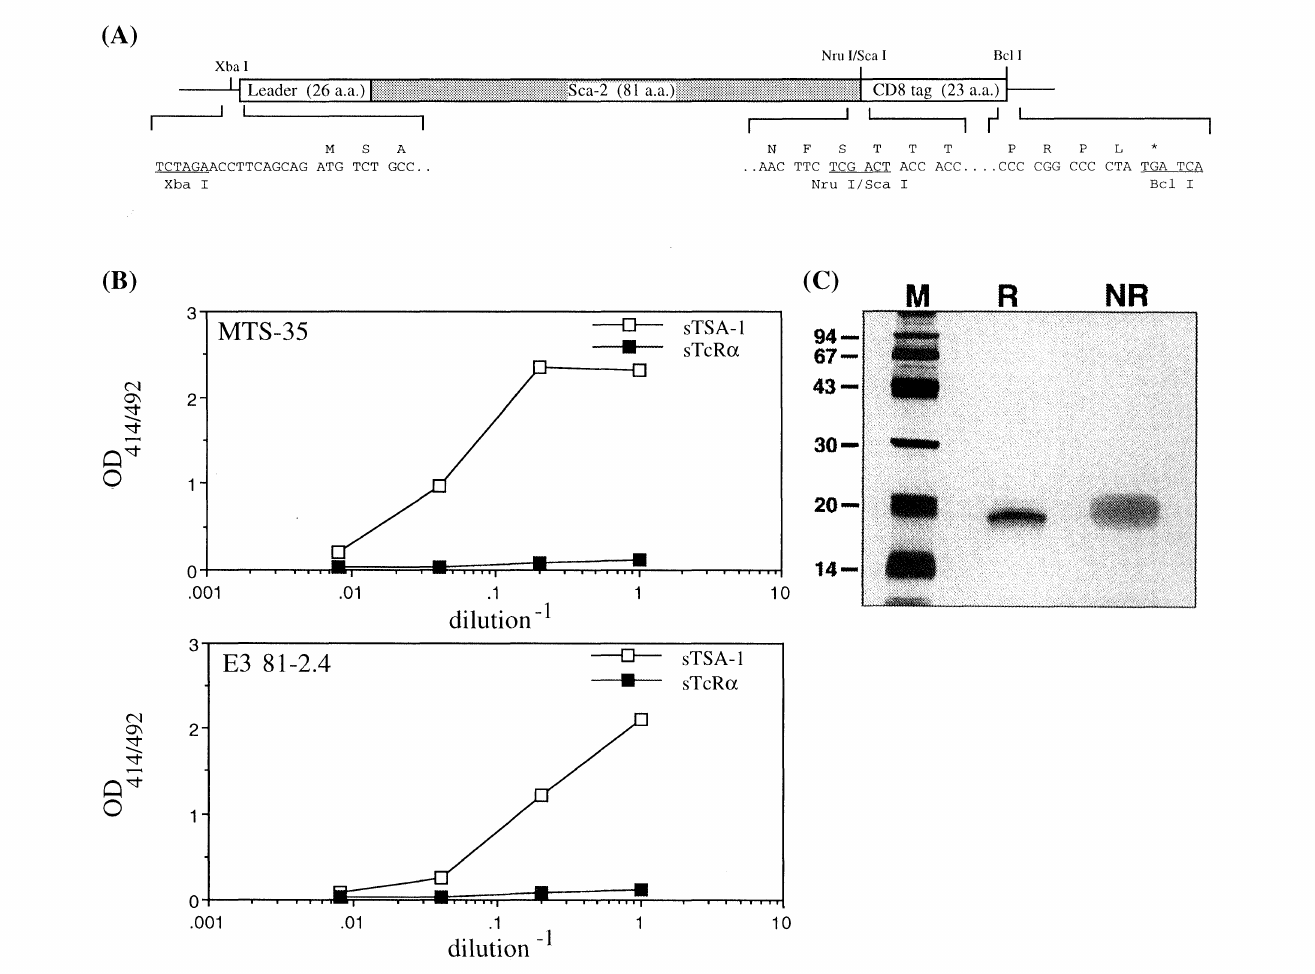
FIGURE 2 Expression of TSA-1/CD8 fusion protein. (A) The TSA-I cDNA corresponding to the extracellular domain (Classon and Coverdale, 1994) was assembled and expressed in CHO cells as a CD8 fusion protein. (B) ELISA of sTSA-1/CD8 fusion protein with two different TSA-1 mAbs, MTS-35 and E3 81-2.4, as solid-phase capture reagents. (C) SDS-PAGE of immunopurified sTSA-1/CD8 fusion protein. Molecular weight markers (in kilodaltons) are